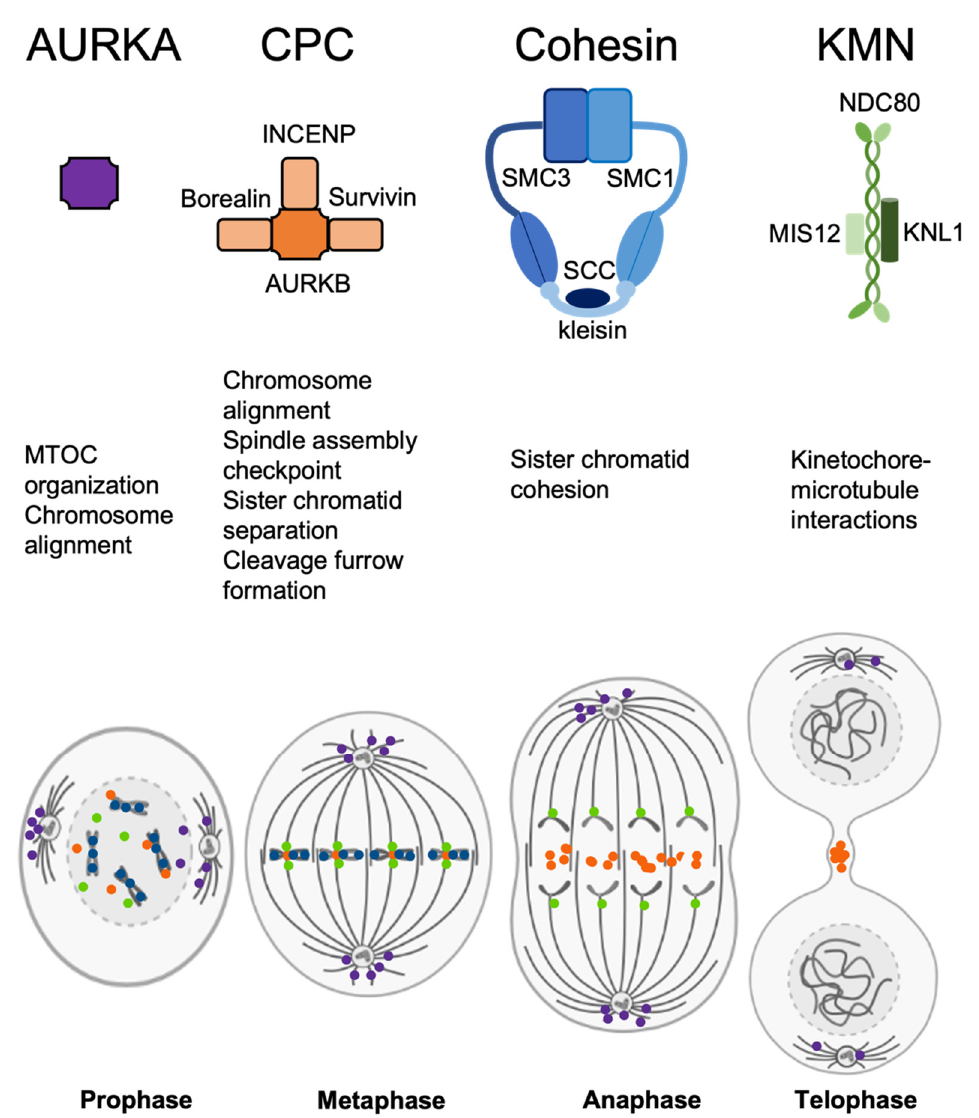
Figure 1. Summary of structure, main functions, and mitotic localization of the protein complexes analyzed in this study. Purple—AURKA, orange—CPC, blue—cohesin,